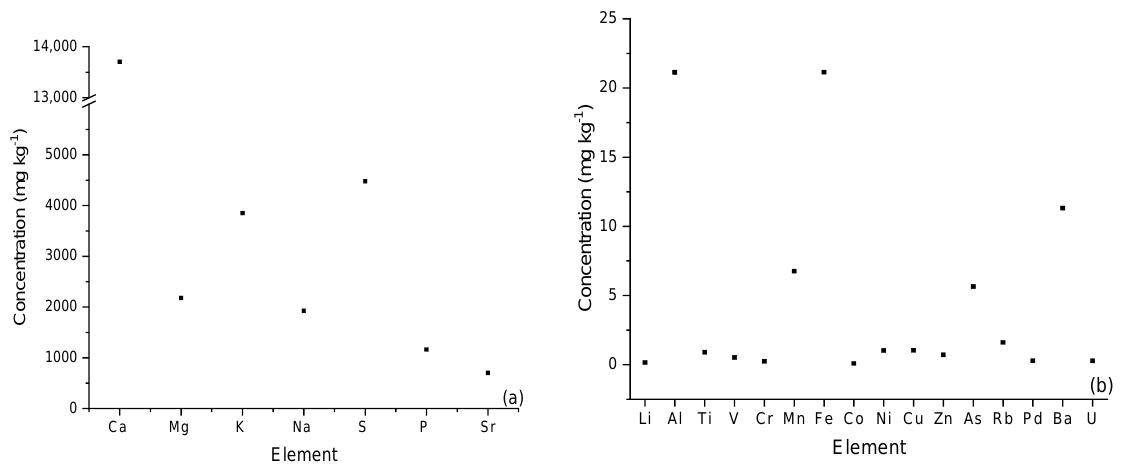
Figure 3. Elemental content (major ( a ) and minor ( b ) elements) of Sargassum biomass determined by ICP-MS and ICP-OES.